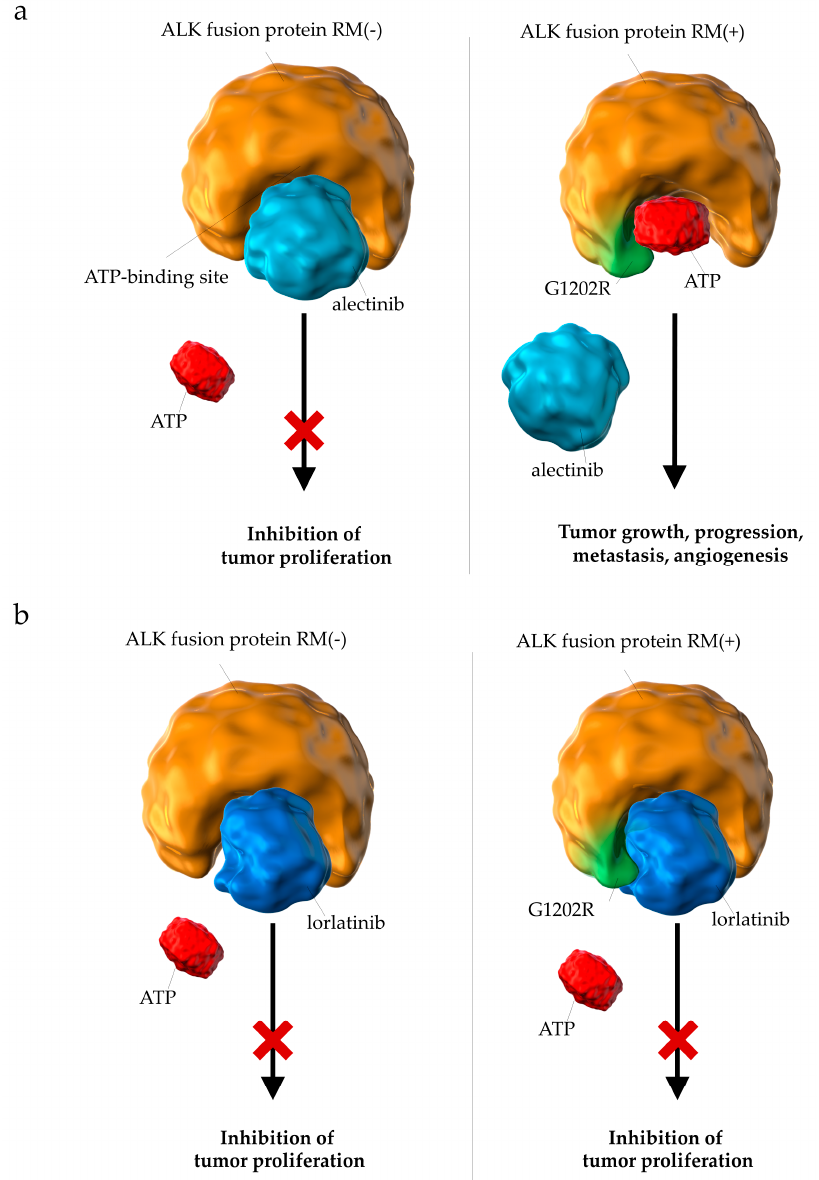
Figure 9. Differences in the pharmacological effects between ( a ) alectinib and ( b ) lorlatinib on ALK fusion proteins with resistant mutations. ( a ) Resistant mutations (e.g., G1202R) prevent the binding of alectinib to the ATP-binding domain of ALK fusion proteins. ( b ) Lorlatinib binds to the ATP-binding pocket of ALK fusion proteins with resistant mutations and successfully suppresses downstream signals involved in tumor growth; ALK, anaplastic lymphoma kinase; RM, resistant mutation; ATP, adenosine triphosphate.